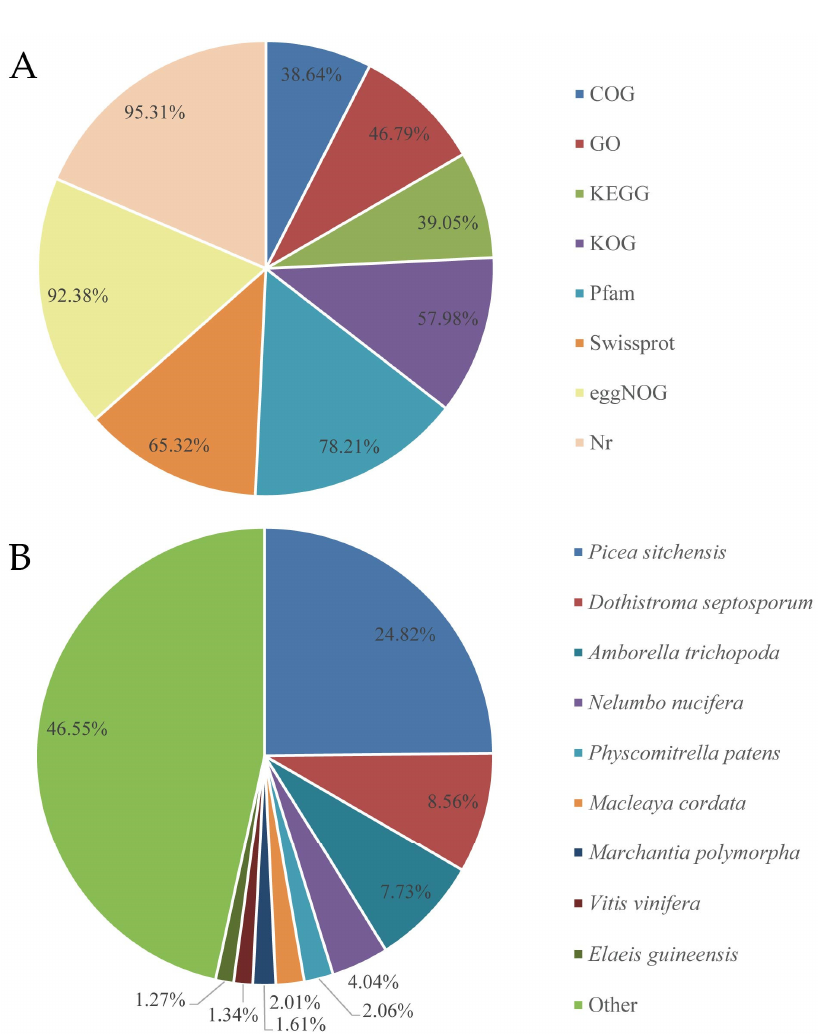
Figure 1. Unigene annotation by searching against public databases. ( A ) Database matches of all the annotated unigenes. NR (NCBI non-redundant protein sequences), Protein family (Pfam), KOG/COG/eggNOG (Clusters of Orthologous Groups of proteins), Swiss-Prot (a manually anno- tated and reviewed protein sequence database), Kyoto Encyclopedia of Genes and Genomes (KEGG), and Gene Ontology (GO). ( B ) Species distribution of all the top BLASTx hits. Annotation of unigenes obtained from combined transcriptomes of 12 cDNA libraries, including samples of T. mucronatum and T. distichum leaves with and without inoculation of P. maculans